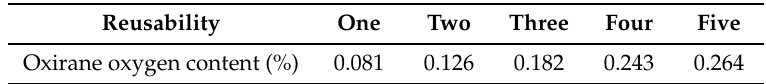
Table 1. Amberlyst D001 (dry) reusability. Experimental conditions: 2-EH/oil ratio of 4:1, 7 wt % Amberlyst D001 (dry), 90 ˝ C, 18